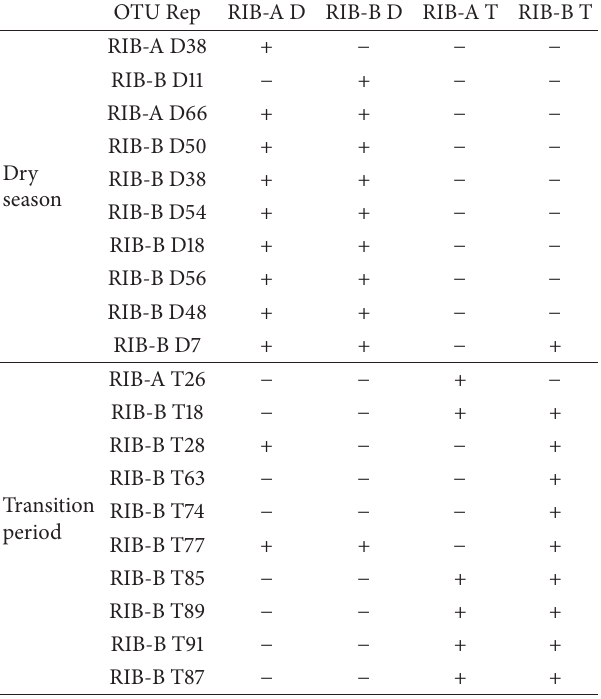
Table 3: Presence of the ten most abundant OTUs from each season among the lake sediments retrieved in the dry season (RIB-A D and RIB-B D) and the transition period (RIB-A T and RIB-B